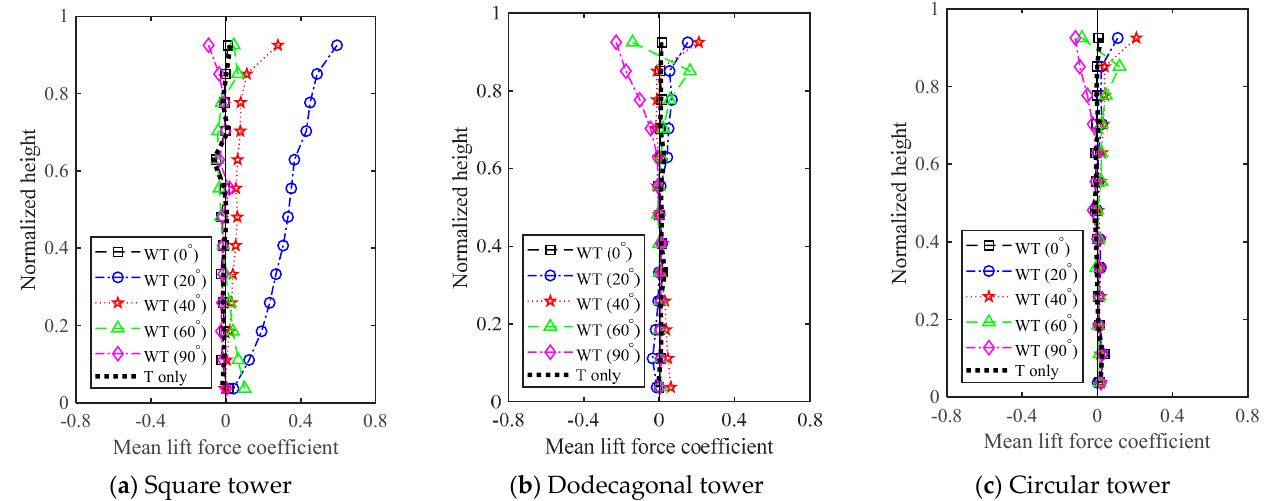
Figure 12. Variation of mean lift force coefficients with number of tower sides at θ pit = 90° and θ azi = 0°.